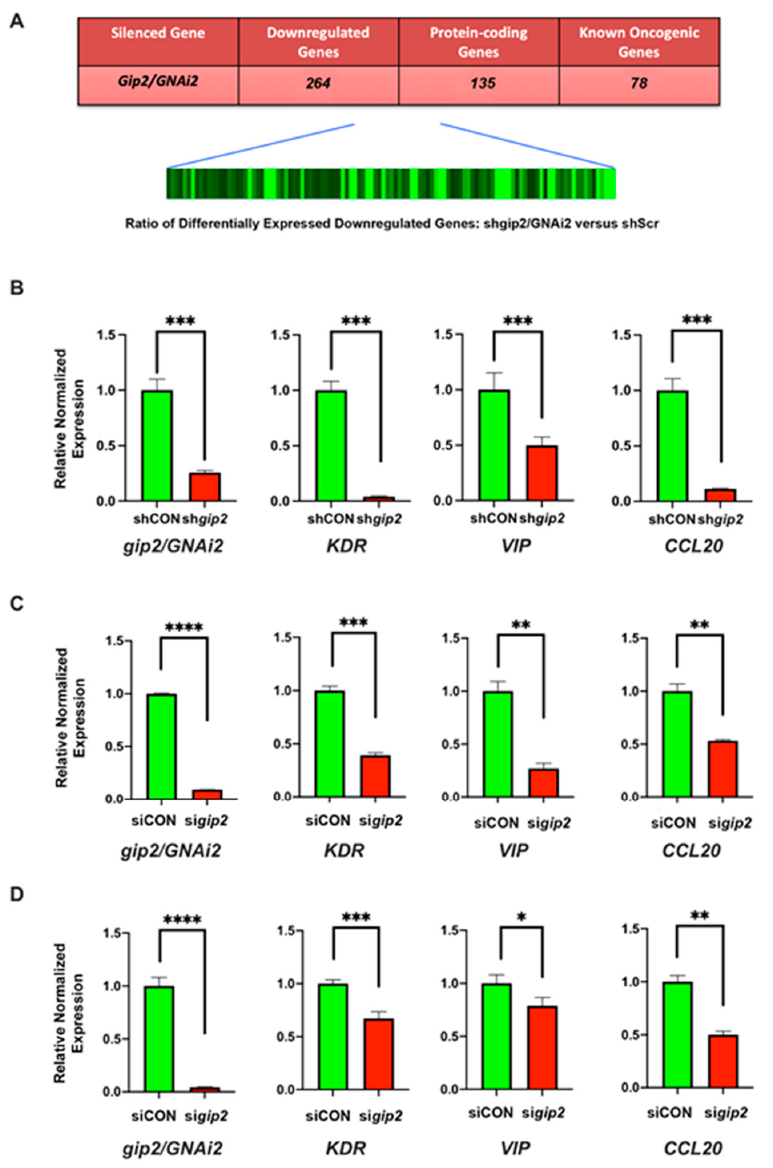
Figure 1. Heatmap of genes downregulated upon silencing of GNAi2/gip2 and validation. ( A ) Heatmap and the downregulated genes. The ratio comparing control cells (scrambled shRNA) and gip2-silenced cells is presented as a heat map. Black and green bands represent unchanged and downregulated expression, respectively. Total number of genes that show > 5-fold reduction in the expression compared to control values is presented as a table insert. Array results were validated by RT-PCR methods using SKOV3 ( B ) Kuramochi ( C ) and OVCAR8 ( D ) cells in which the expression of gip2 was silenced (sigip2) using specific shRNA or siRNA. In SKOV3 cells, cells stably expressing scrambled shRNA (shCON) were compared with cells in which gip2/GNAi2 was silenced with the stable expression of specific shRNA targeting gip2/GNAi2 (shgip2). In Kuramochi and OVCAR8 cells, cells transfected with non-targeting scrambled siRNA pool were used as the control group (siCON). Downregulated genes were validated by monitoring the expression of the representative genes KDR, VIP, and CCL20 by RT-PCR. Statistical significance between gip2-knockdown and scrambled siRNA cells was determined by Student’s t-test (*P < 0.05, **P < 0.005, ***P < 0.0005, ****P < 0.0001ACKR3).